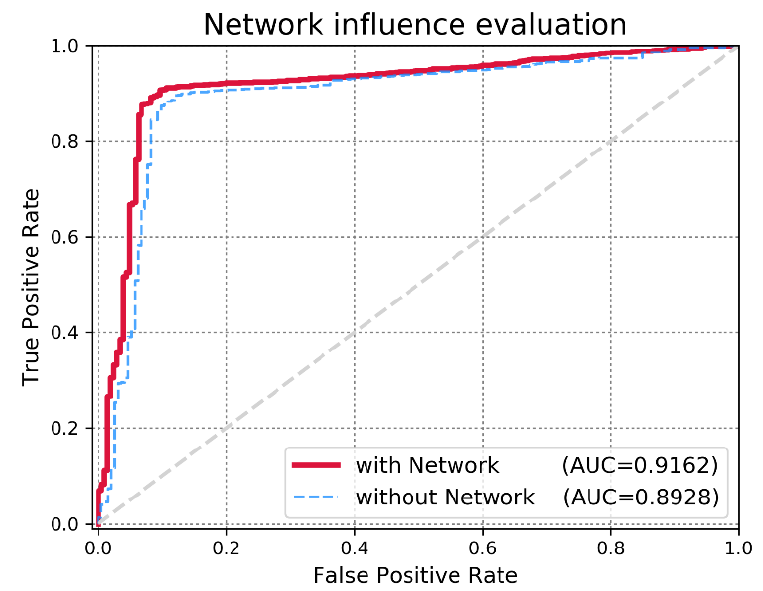
Figure 5. Performance evaluation on IMDN with the miRNA functional similarity network and without the miRNA functional similarity network.